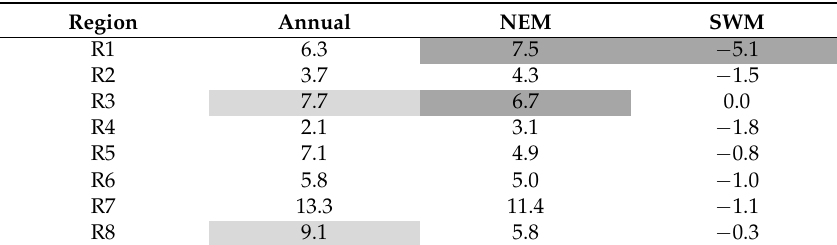
Table 3. Annual and monsoons rainfall trends (mm/year) of eight distinct climatic regions for the period of 1976–2006.